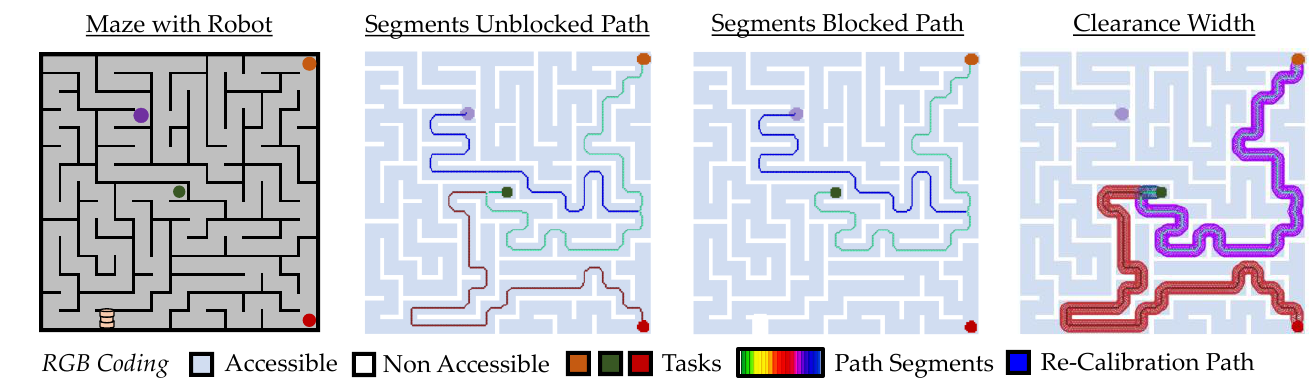
Figure 20. Path generation of a labyrinth: RGB map, path generation without blockade, path generation with blockade, clearance width.